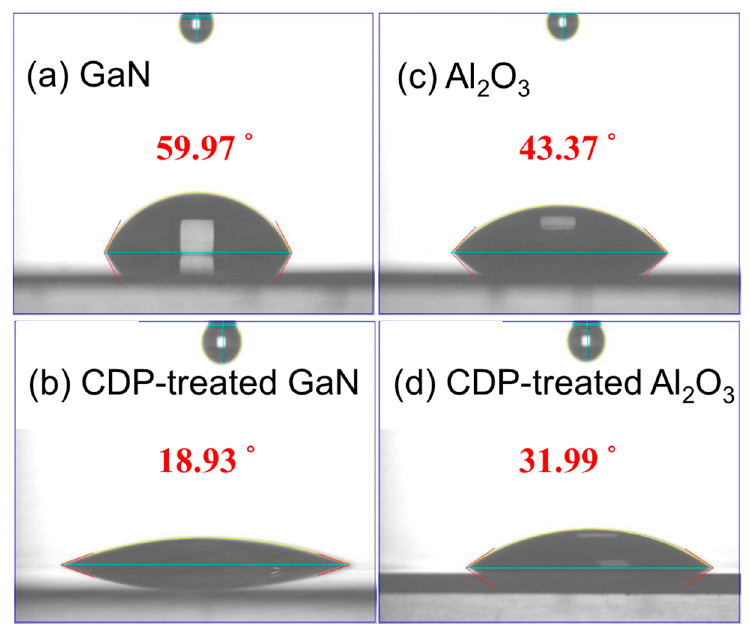
Figure 2. Contact angle of DI water performed on ( a ) GaN; ( b ) corona-discharge plasma (CDP)-treated GaN; ( c ) Al 2 O 3 ; and ( d ) CDP-treated Al 2 O 3 .